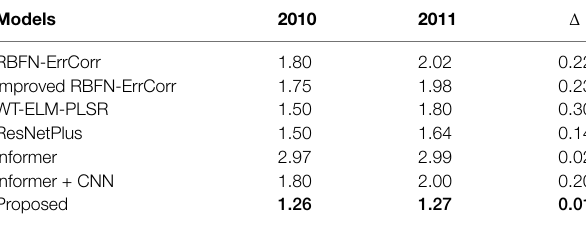
The bold values are the best results as compared to the others.